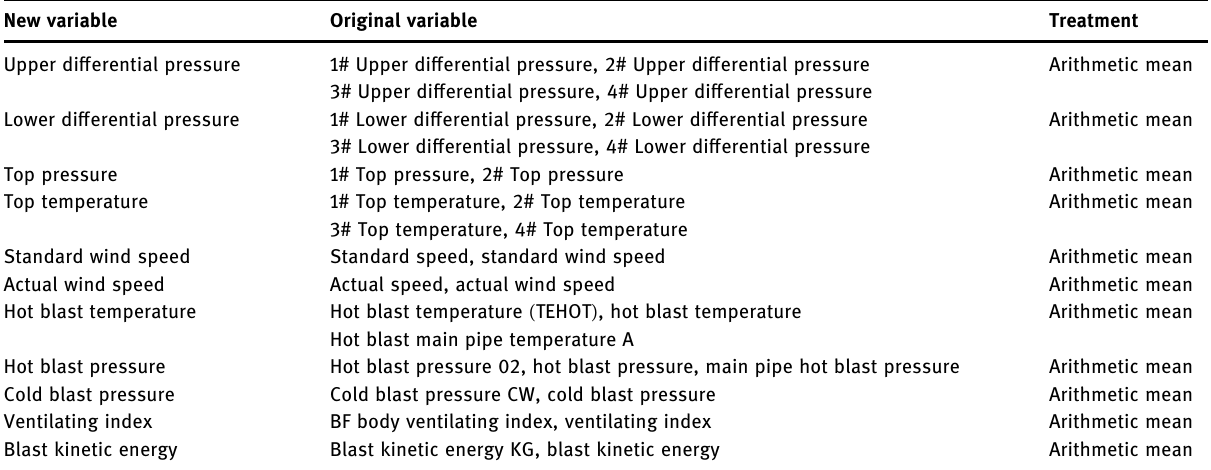
Table 1: Variable consolidation